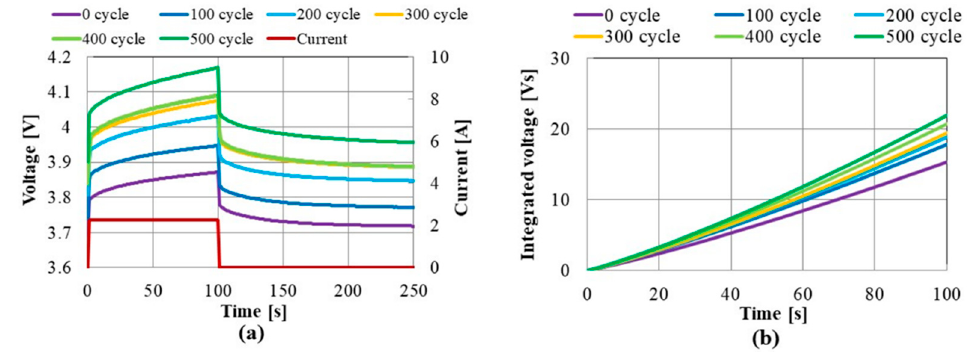
Figure 5. Effect of charging cycle. ( a ) Voltage. ( b ) Integrated voltage.